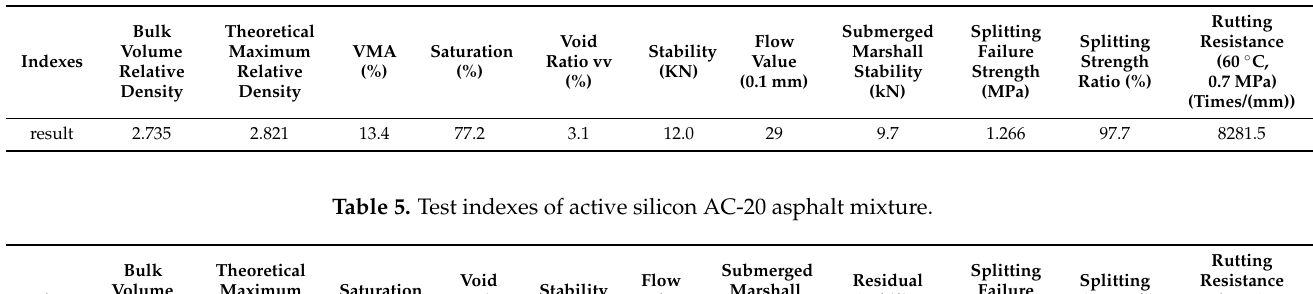
Figure 4. Gradation curve of asphalt mixture. Table 4. Test indexes of active silicon AC-13 asphalt mixture.